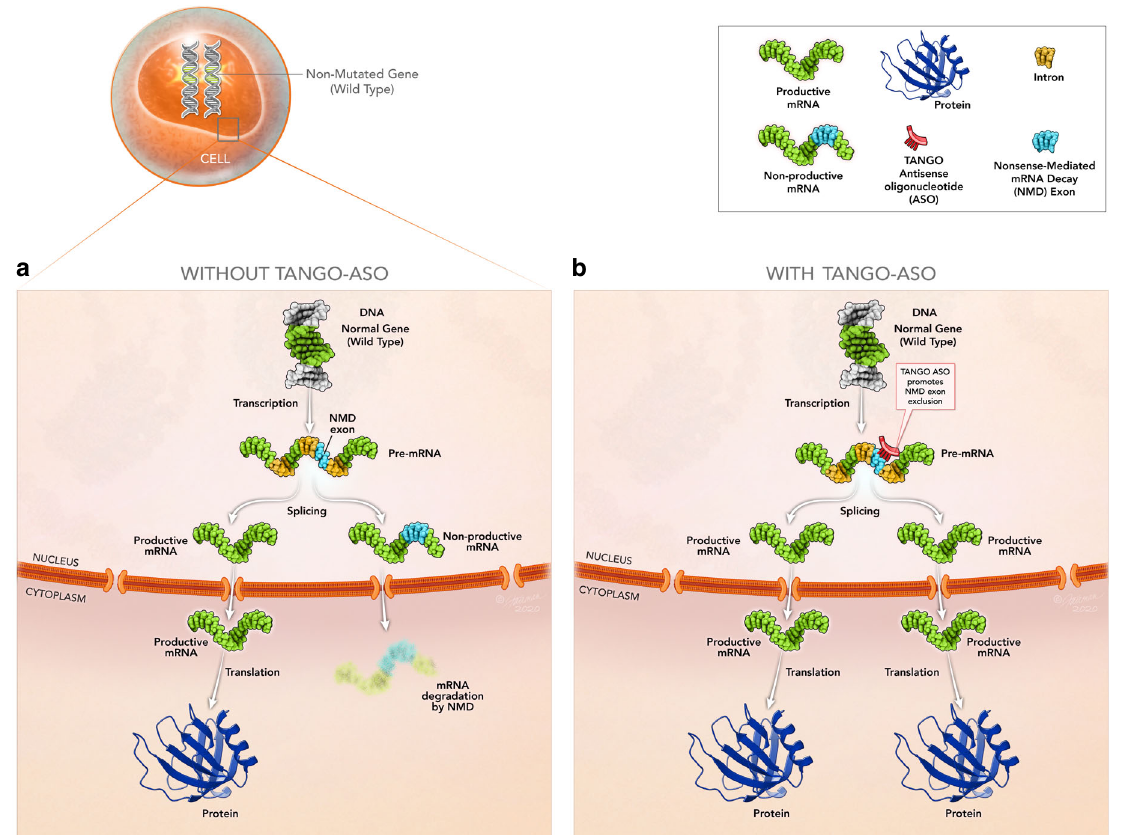
Fig. 7 TANGO ASOs prevent NMD to increase productive mRNA and protein. a Example of a cell expressing a pre-mRNA that is alternatively spliced to generate a productive mRNA and a non-productive mRNA. While the non-productive mRNA is degraded by NMD, the productive mRNA is translated into protein. b Example of a cell treated with a TANGO ASO targeting the non-productive AS event (e.g. exon inclusion) and preventing the inclusion of